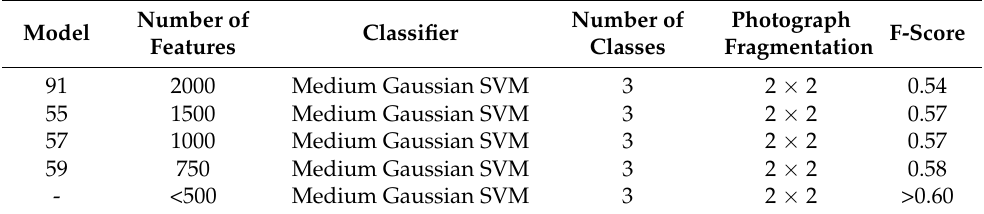
Table 3. Comparison between the number of features extracted and the model accuracy with a medium Gaussian SVM classifier.